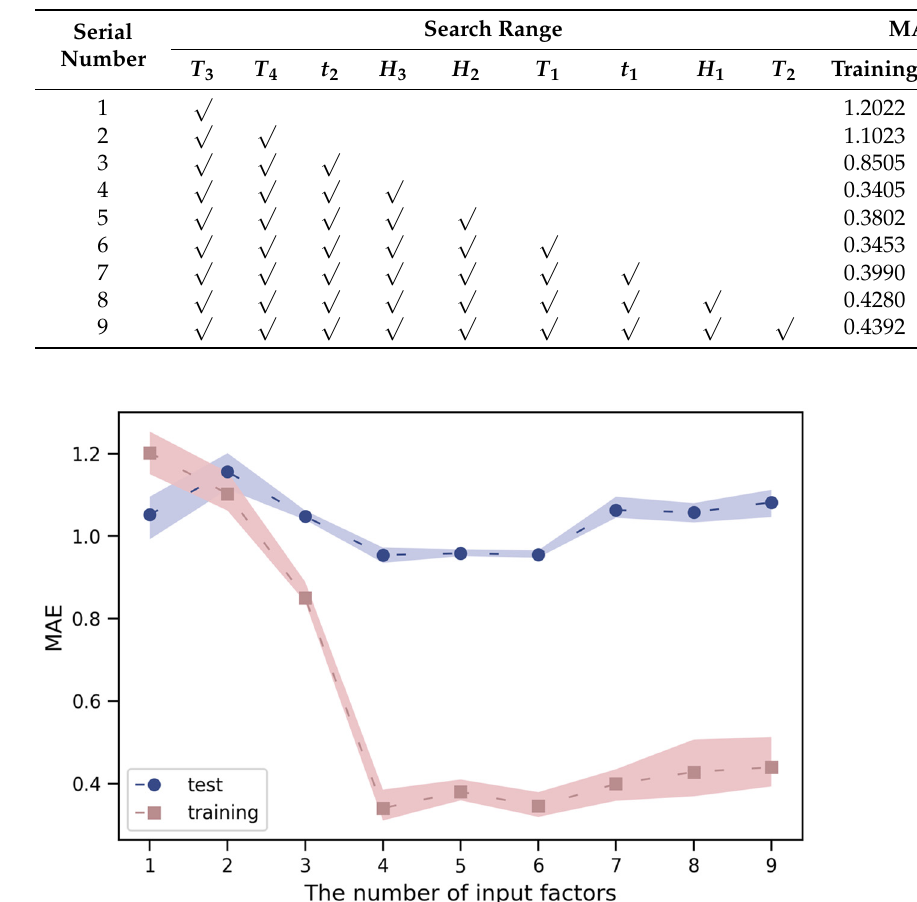
Figure 10. The MAE values of each group under ten ‐ fold cross ‐ validation.